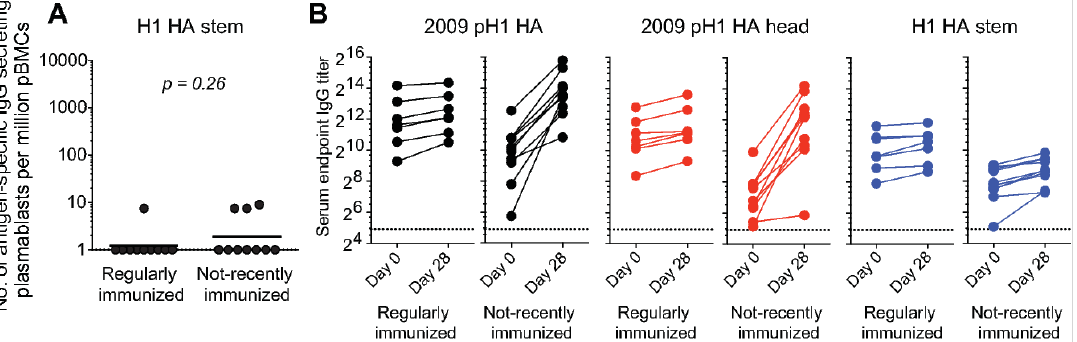
Figure 4. Poor boosting of anti-HA stem antibodies following seasonal vaccination. Healthy adult volunteers were vaccinated with the 2012/13 inactivated seasonal influenza vaccine ( n = 20). ( A ) Frequency of IgG-secreting plasmablasts directed against the vaccine antigen in regularly immunized ( n = 10) and not-recently immunized ( n = 10) subjects. ( B ) Pre- and 28 d post-vaccination serum IgG antibody titers against the 2009 pandemic H1 HA (left, black), pandemic H1 HA head region (middle, red), and H1 stem region (right, blue). Each symbol represents one individual ( n = 10/group). Unpaired Student t tests were used to derive p values.